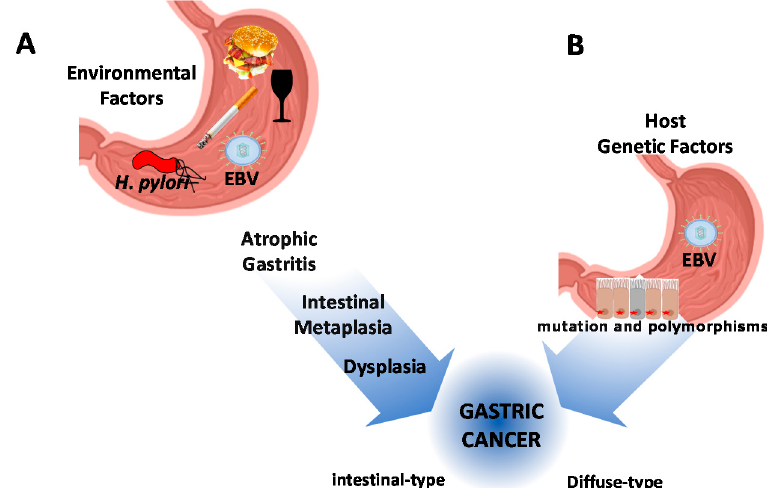
Figure 1. Schematic representation of gastric cancer pathogenesis. ( A ) T he contribution of environmental factors, nutrition, and infectious agents. Chronic infection by Helicobacter pylori is considered the main infectious agent in combination with diet, smoking, and alcohol. All these conditions drive the precancerous cascade of the intestinal ‐ type of gastric cancer. ( B Host genetic factors, including hereditary cancer susceptibility syndromes, drive the carcinogenesis process of diffuse ‐ type gastric cancer. The Epstein/Barr virus (EBV) latent infection has been described as associated with both subtypes of gastric cancer (GC).